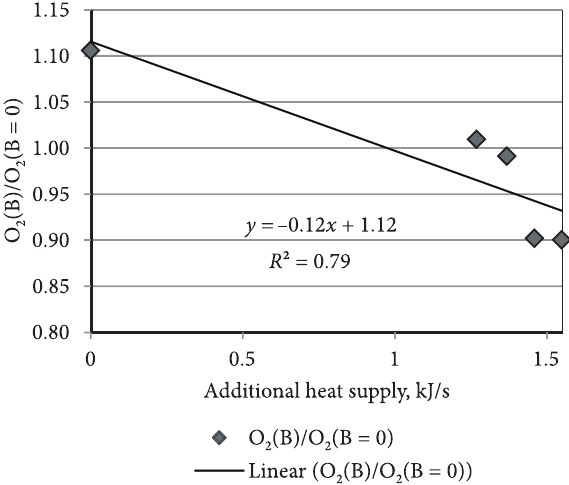
Fig. 11. Influence of propane-butane supply on CO CO (B = 0) and CO(B)/CO(B = 0) 2